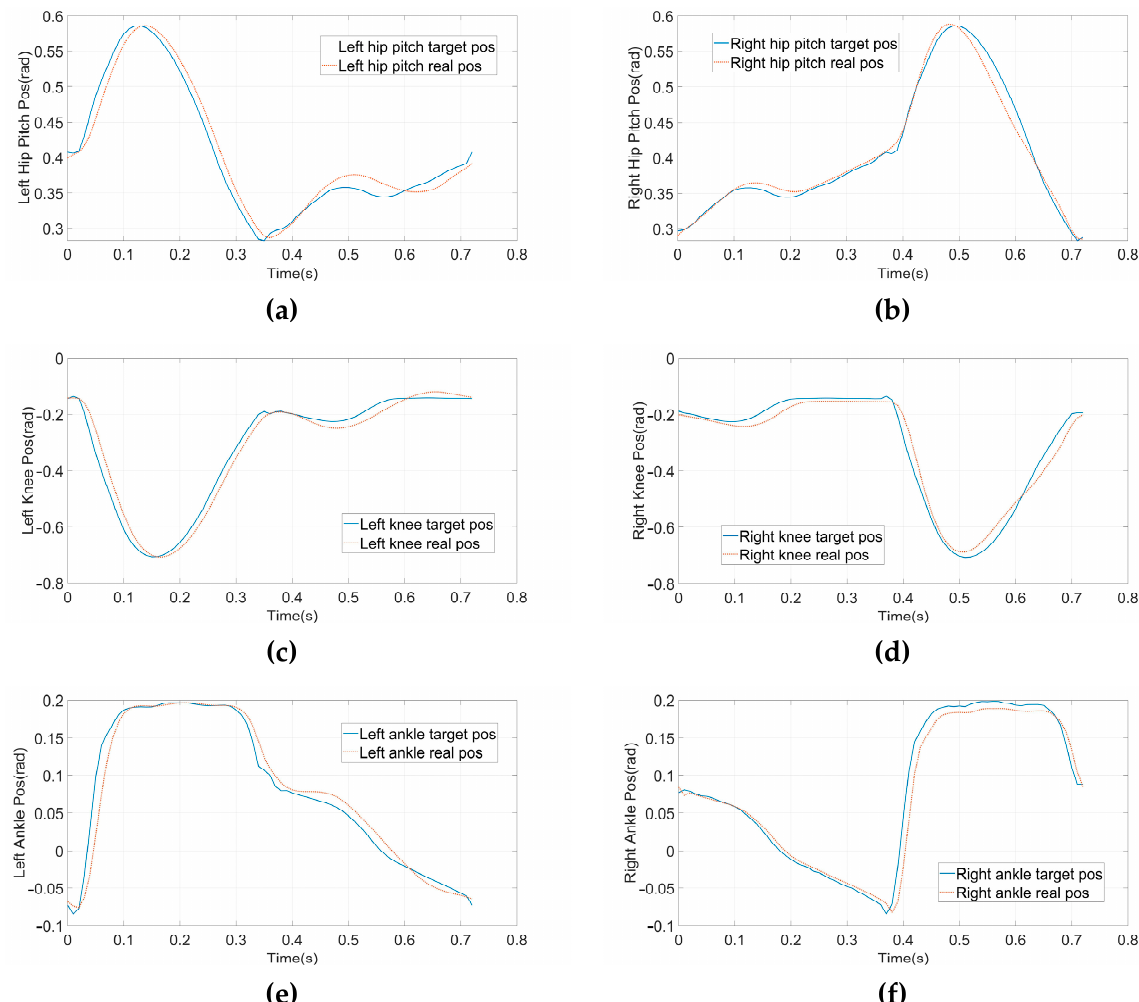
Figure 6. Generated position trajectories and tracking performance in CoppeliaSim. ( a ) Left Hip Pitch position. ( b ) Left Hip Pitch position. ( c ) Left Knee position. ( d ) Right Knee position. ( e ) Left Ankle position. ( f ) Right Ankle position.